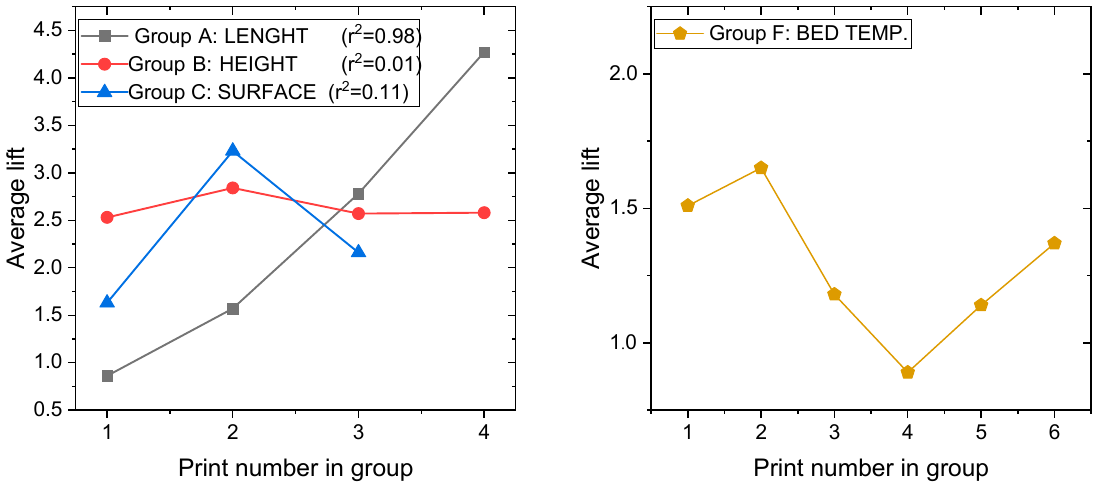
Figure 11. Plots of selected measurements. ( Left ): Groups A–C with correlation coefficients. ( Right ): Group F.